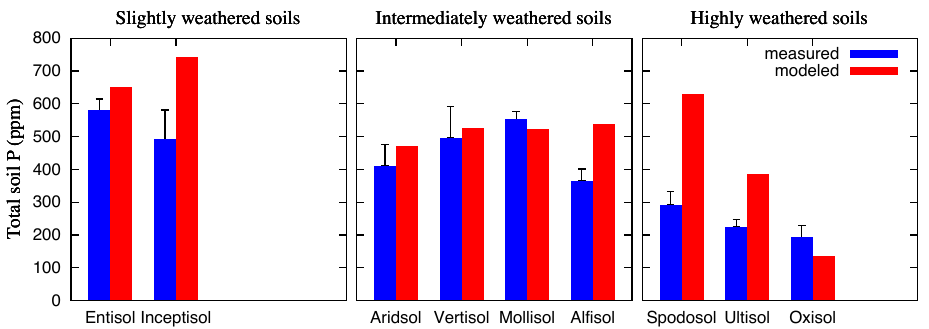
Fig. 4. The comparison of estimated total P with field measurement of total P concentration (mean with one standard error, based on Hedley fractionation data from the literature (Yang and Post, 2011)) for soil orders grouped into three weathering